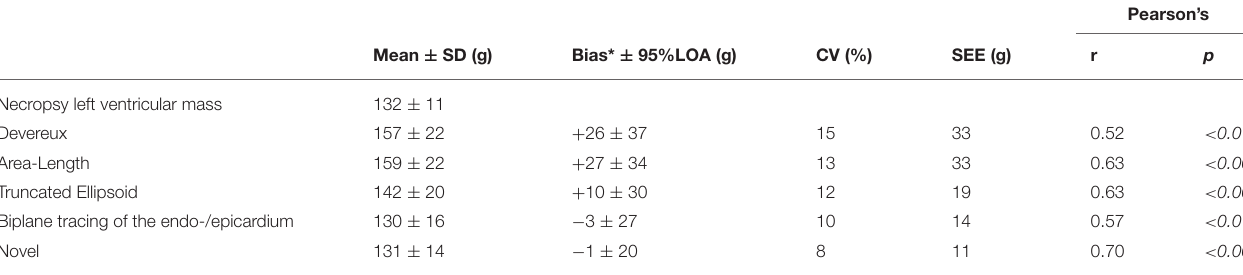
TABLE 3A | Accuracy of various methods for left ventricular mass quantification among all pigs ( n = 34).